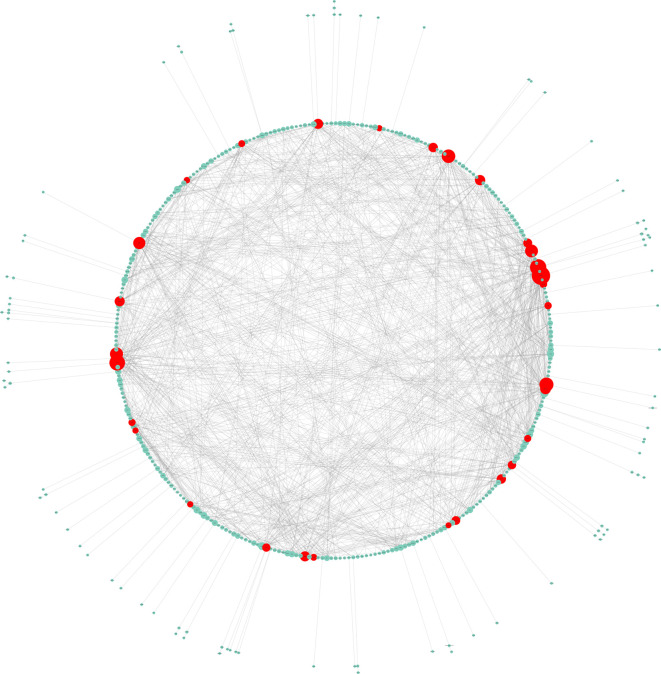
Hub genes selection and analysis. The PPI network of DEGs comprised 334 nodes and 1,568 edges.